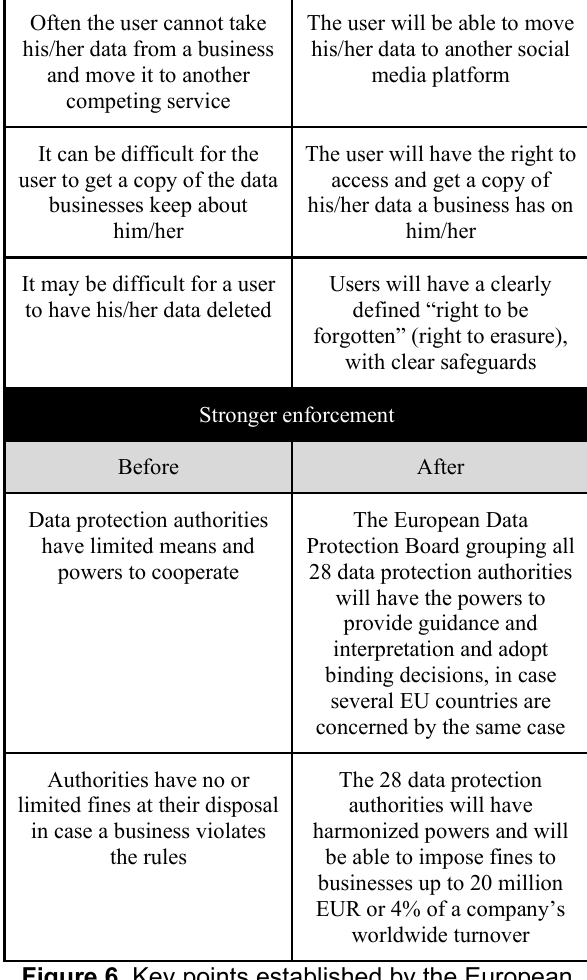
Figure 6. Key points established by the European General Data Protection Regulation (Source: https://ec.europa.eu/commission/sites/beta- political/files/data-protection-factsheet- changes_en.pdf)